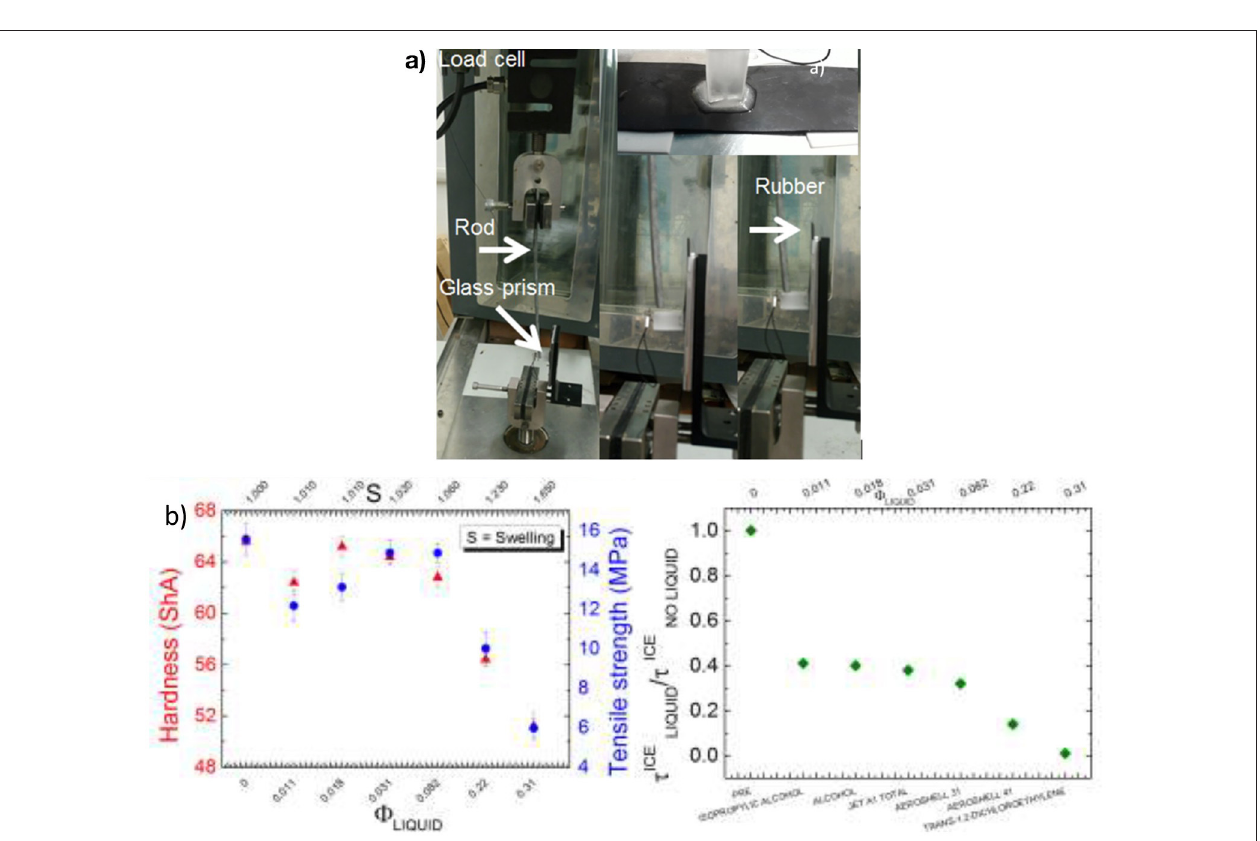
FIGURE 2 | (a) Measurements of adhesive strength of a glass prism frozen on swollen elastomer. The inset shows the glass prism frozen on elastomer. (b) Mechanical properties and predictive model of ice adhesion as a function of different adsorbed liquid where Φ LIQUID = volume fraction of absorbed liquid, S = swelling, τ ICE LIQUID = strength adhesion of ice on swollen rubber and τ ICE NO LIQUID = strength adhesion of ice on un-swollen rubber.